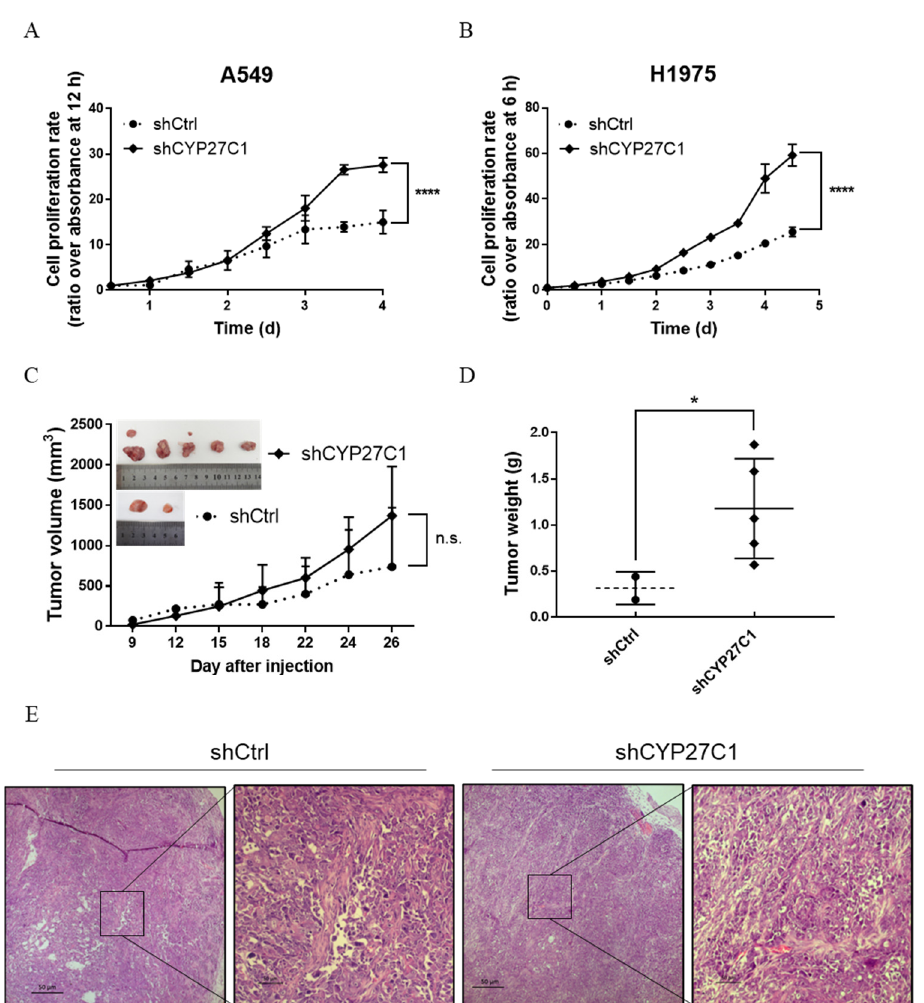
Figure 5. Stable CYP27C1-knockdown promotes human lung cancer cell proliferation in vitro, and in xenograft mice model. ( A , B ) Cell viability of A549-shCYP27C1, H1975-shCYP27C1, and the corresponding control cells was detected by MTS assay at different time points. Time-cell proliferation curves were plotted, and analyzed by two-way ANOVA. ****, p < 0.0001. ( C ) BALB/c nude mice (N = 10) were divided into two groups. H1975-shCYP27C1 cells were injected into the right armpit of the mice in experimental group, whereas H1975-shCtrl cells were injected into mice in control group. Tumor formed on the ninth day. Length ( l ) and width ( w ) of the tumor was measured on 12, 15, 18, 22, 24, and 26 days after injection. Tumor volume was calculated by formula: V = (l×w 2 )/2 . Time-tumor volume curve was plotted, and analyzed by two-way ANOVA. n.s., p > 0.05. ( D ) Mice were sacrificed on the twenty-seventh day after injection. Mice were dissected, tumor weight was measured, and analyzed with Mann–Whitney test. *, p < 0.05. ( E ) Histology (hematoxylin-eosin staining) of representative xenograft tumor in nude mice model. Magnification: 50× ( panel 1,3 ); 200× ( panel 2,4 ).